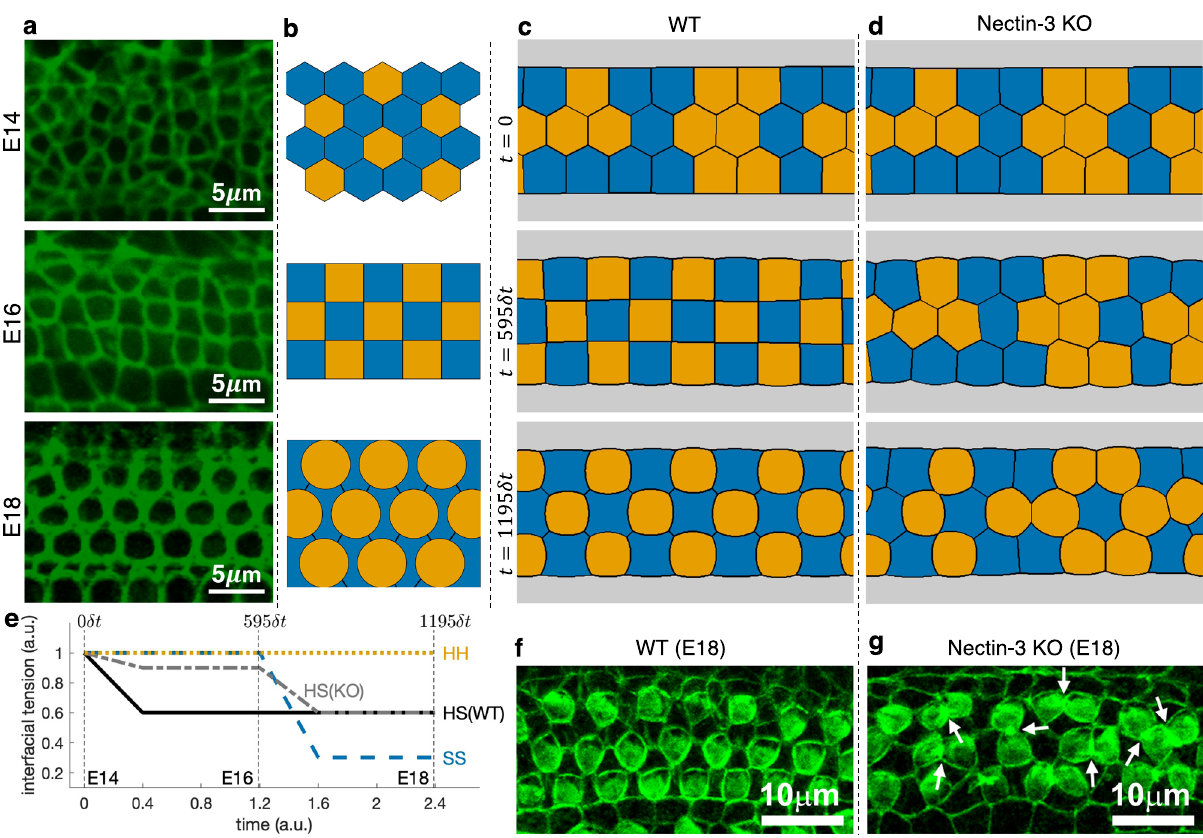
Fig. 5 Actual images and simulation results of a developing auditory epithelium. a Localization of junctional marker (ZO-1) at the apical surface of the auditory epithelium at embryonic days E14, E16, and E18 (reproduced from Front. Cell Dev. Biol., ⓒ 2016 Togashi 11 ). b Schema of the distribution of hair cells (HC, orange) and supporting cells (SC, blue) observed in experiments (adapted from Front. Cell Dev. Biol., ⓒ 2016 Togashi 11 ). c , d Simulations of cellular rearrangements of WT ( c ) and Nectin-3 KO ( d ) embryonic auditory epithelium from initial aggregate of 12 HCs (orange), 12 SCs (blue), and one pillar cell (gray), generated employing level set-based model. e Plot of evolution of interfacial tensions at SS (blue dashed line), HS (WT: black solid line, KO: gray dash-dotted line), and HH (orange dotted line) junctions used for the simulations in ( c , d ) (Supplementary Data 4). f , g Actual images of auditory epithelium of WT mouse and Nectin-3 KO mouse at E18 stage, with arrows indicating aberrantly attached HCs (reproduced from Science, ⓒ 2011 Togashi et al. 12